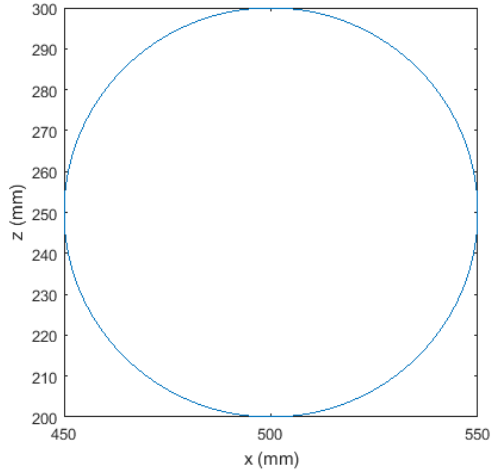
Figure 14. Full-circle validation trajectory.